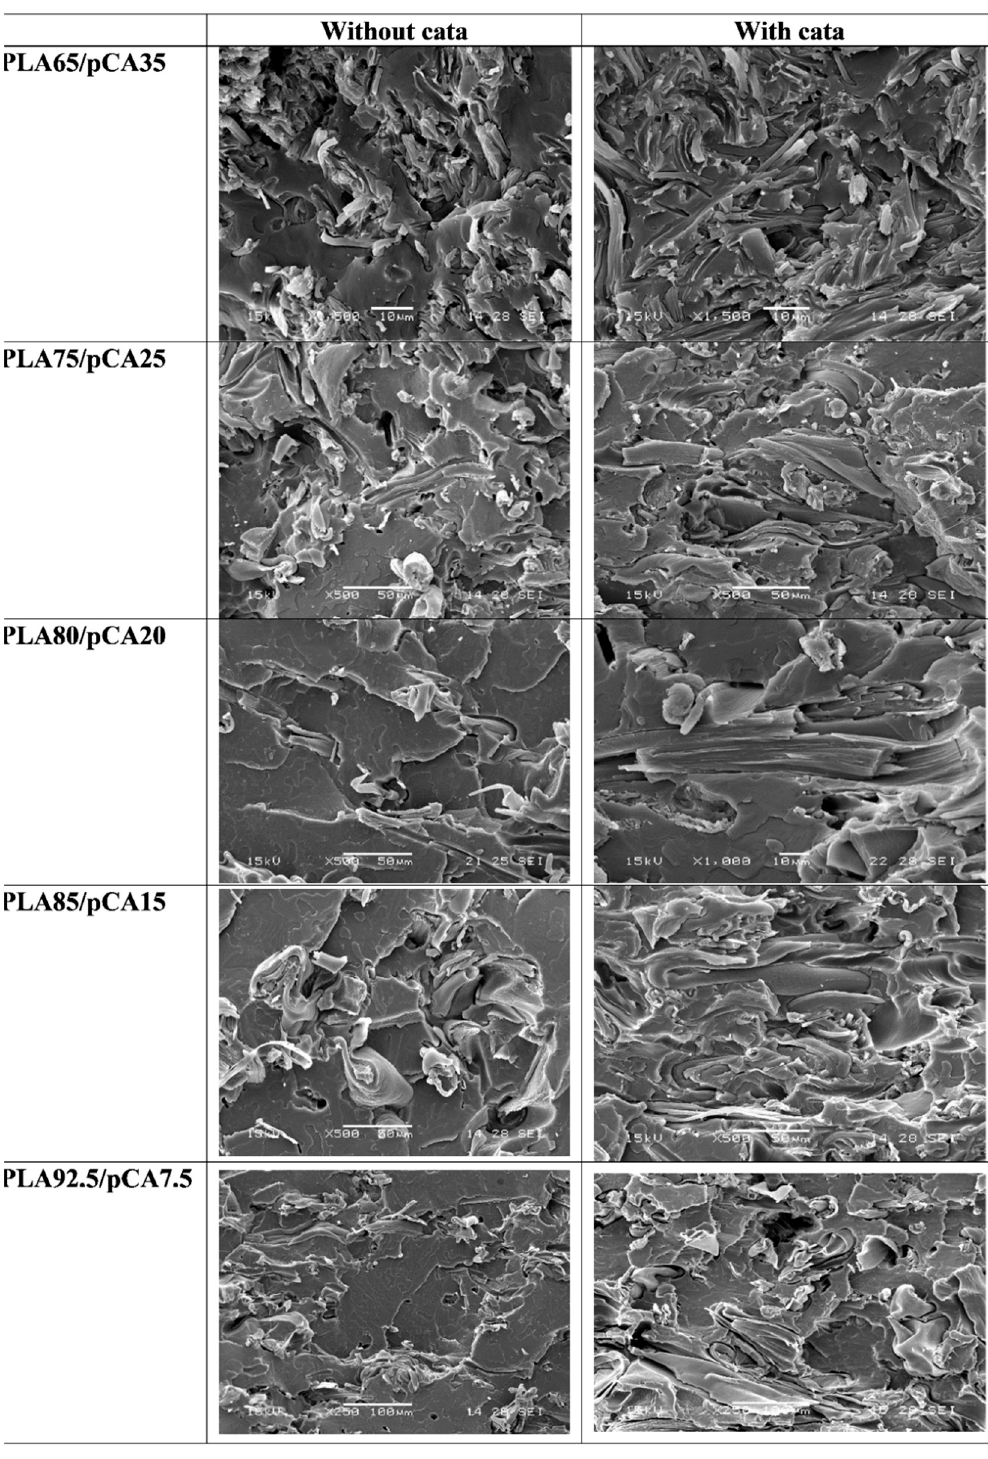
Figure 8. Scanning electron micrographs related to the PLA/pCA blends prepared at 197 °C with and without TBATPB.